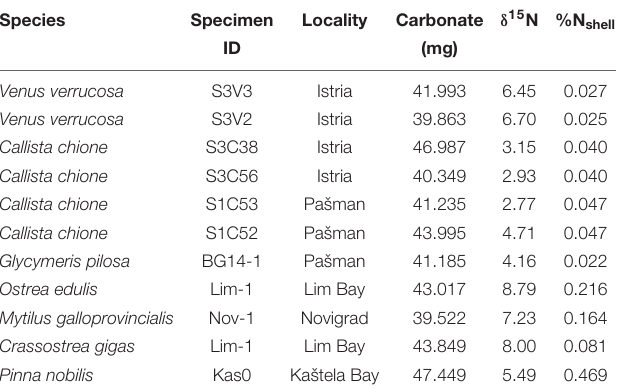
TABLE 2 | Results of preliminary study of δ 15 N CBOM on bivalve species from the Adriatic